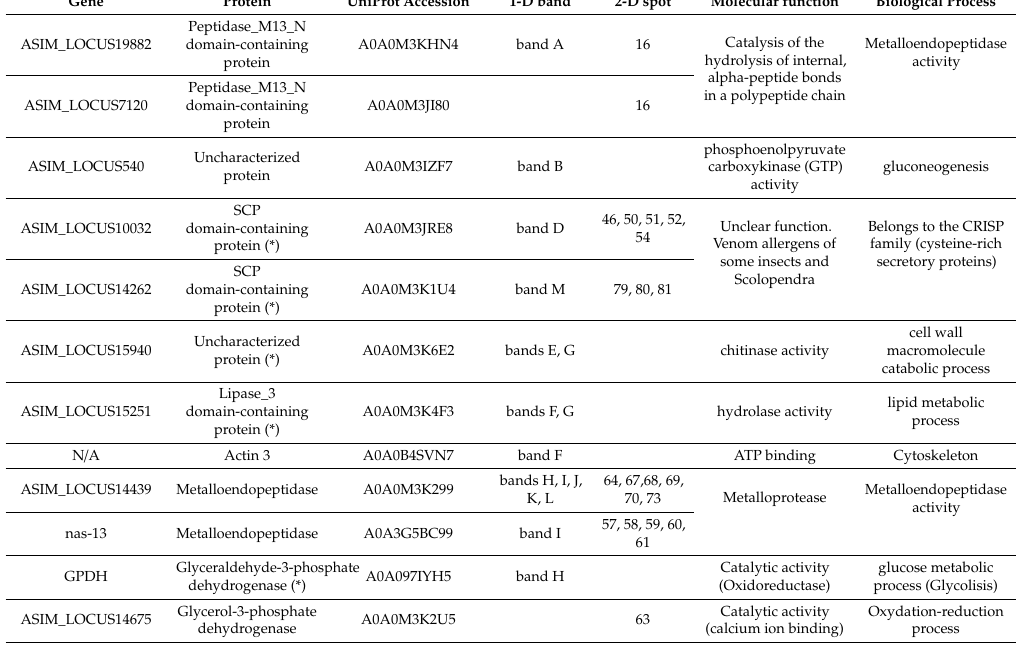
Table 2. Identified and assigned proteins based on higher score of Table 1, with important molecular functions and biological processes. (*) are allergen